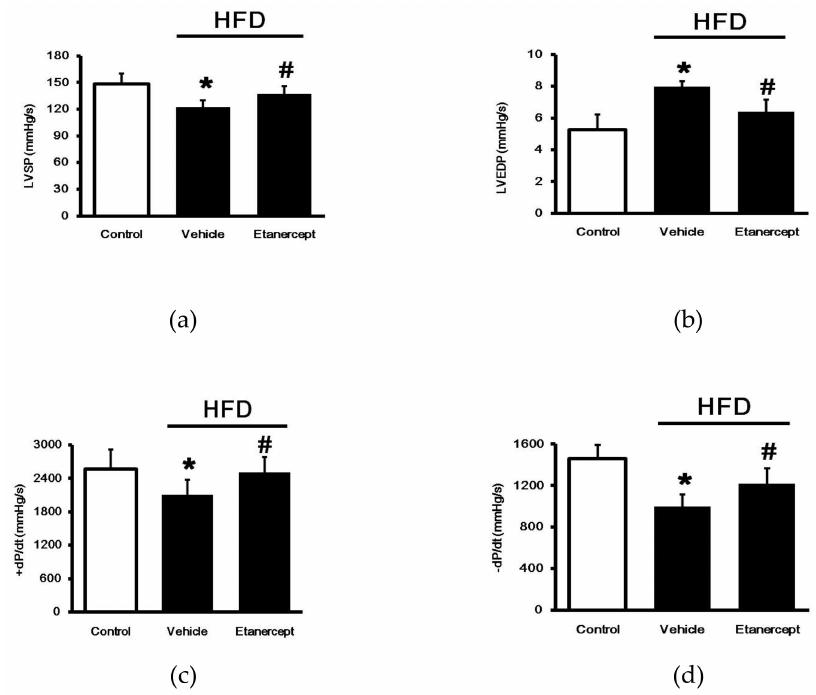
Figure 1. Effects of etanercept on cardiac performance in HFD-fed rats. Ventricular hemodynamic parameters in each group. ( a ) LVSP, ( b ) LVEDP, ( c ) +dp/dtmax and ( d )-dp/dtmax. Treatment with etanercept reversed the changes in cardiac performance (+dP/dtmax and -dP/dtmax) in the HFD-fed rats. The data are shown as the mean ± standard deviation ( n = 6). * p < 0.05 vs. normal control group; # p < 0.05 vs. vehicle-treated group, one-way ANOVA, followed by Bonferroni test. LVSP,